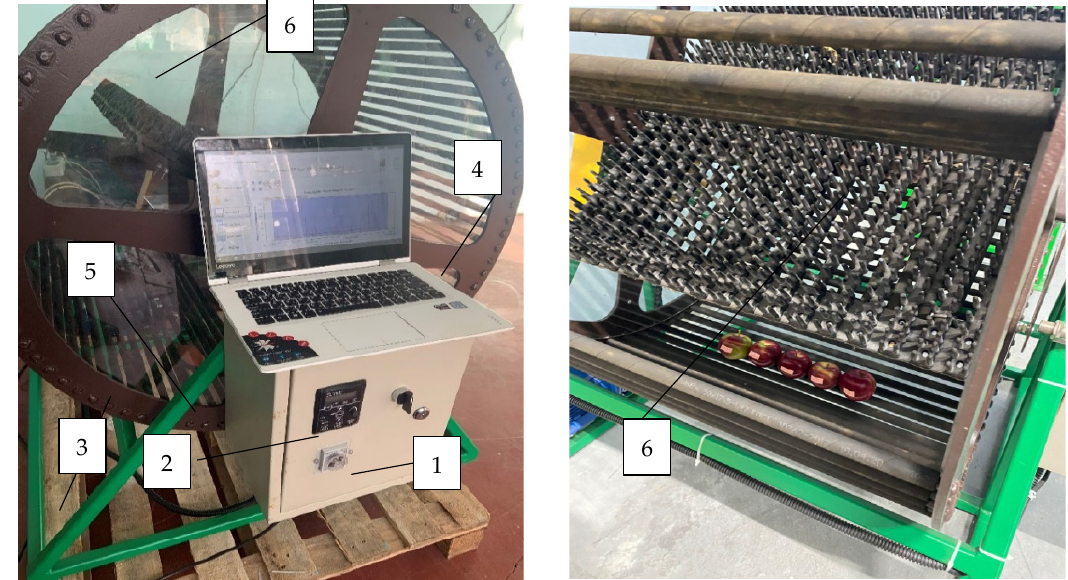
Figure 2. General view of the laboratory installation to assess the force impact of the prototype device for assessing the suitability of varieties and hybrids for mechanized harvesting: 1—ground support; 2—control cabinet; 3—drum; 4—personal computer; 5—data logger; 6—finger-type slide.